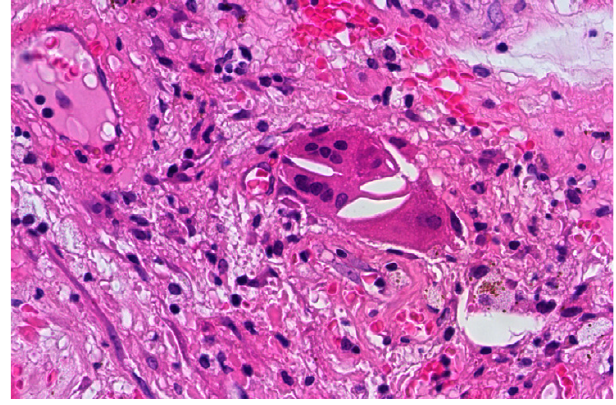
Figure 5 Coats' disease: histopathological findings. Intraretinal choles- terol deposition triggering a giant cell reaction foreign-body type (H&E. Original magnification ×